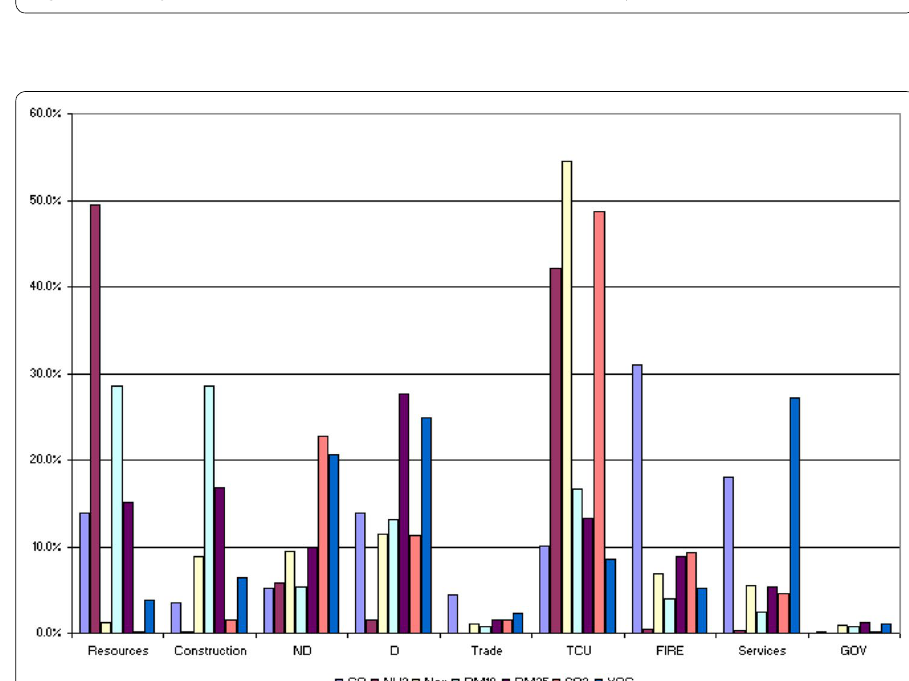
Fig. 10 Sectoral percentage of seven air pollutant emissions in 2050 under the fixed